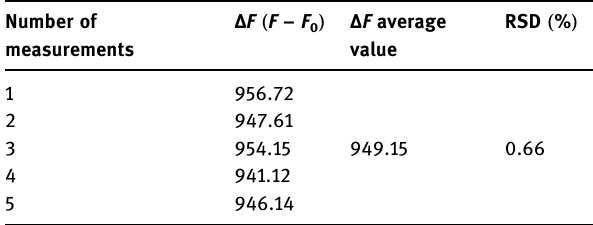
Table 2: Precision test results of probe detection of FEL